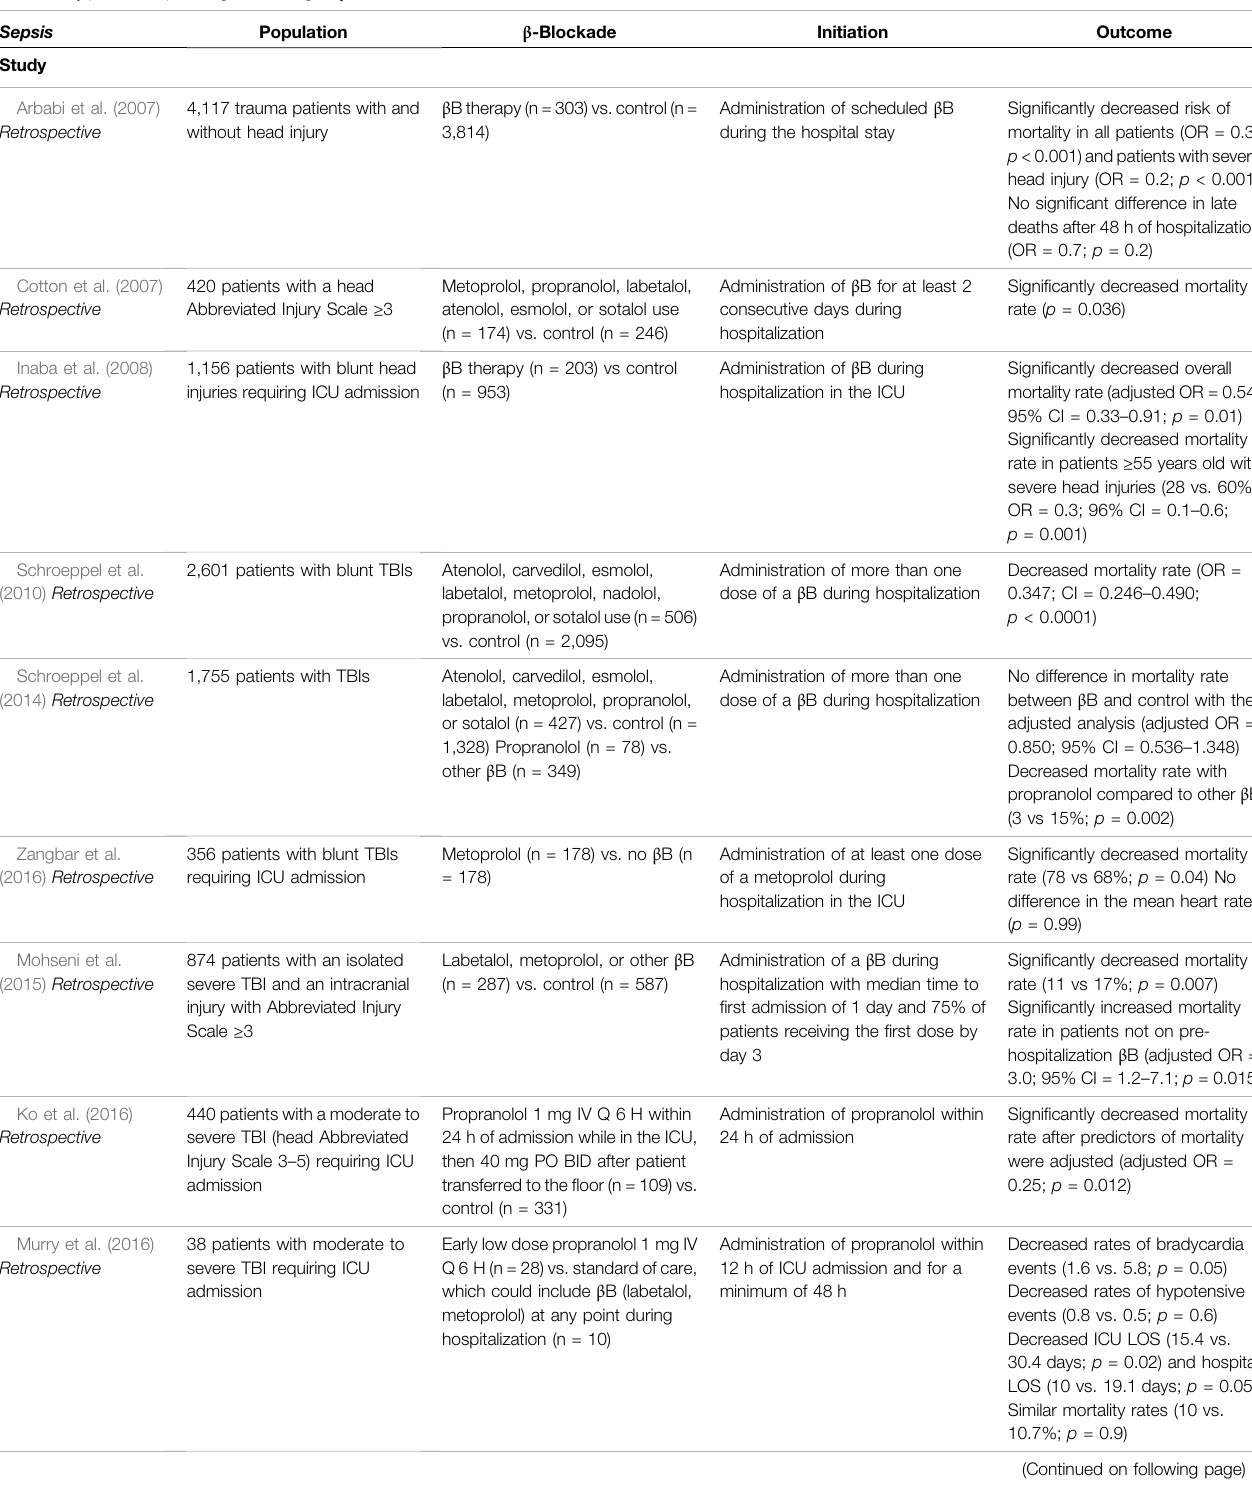
TABLE 1 | ( Continued ) Dosing and timing of β B in critical